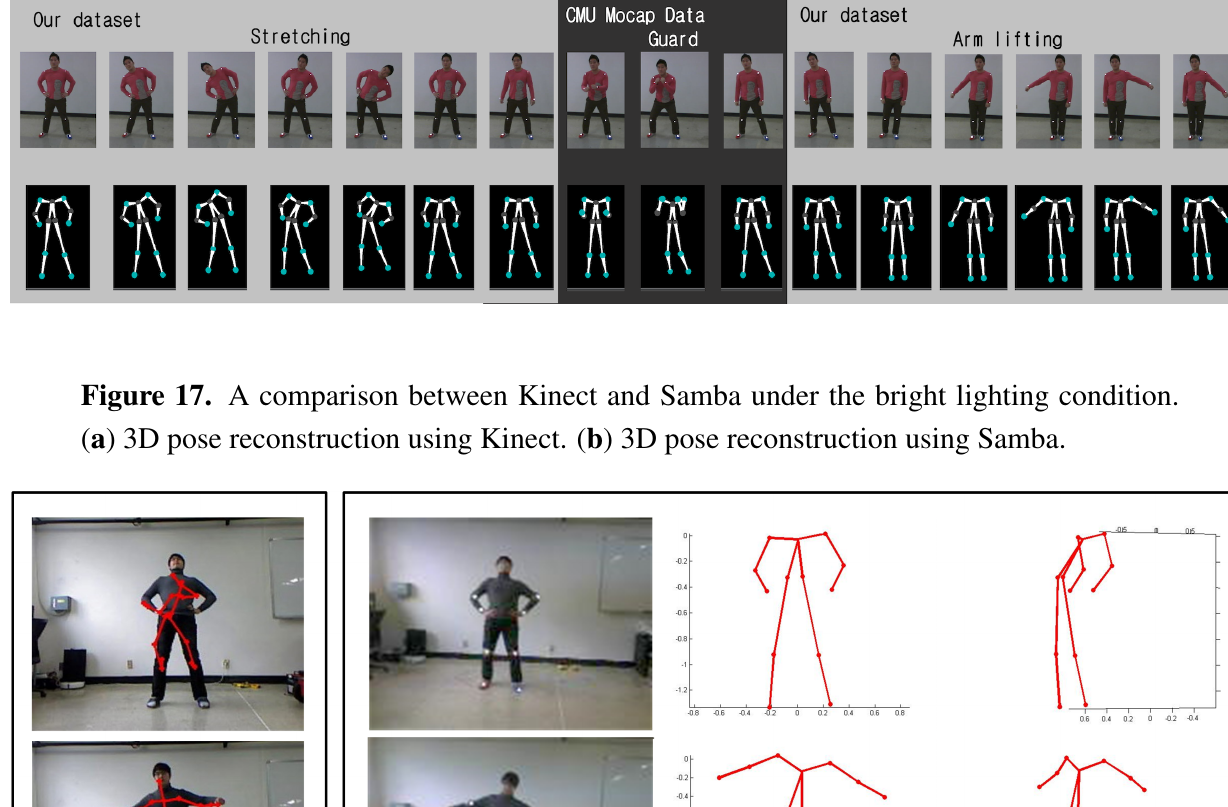
Figure 16. Reconstruction of a composite action: stretching (local), guard (CMU) and arm lifting (local).